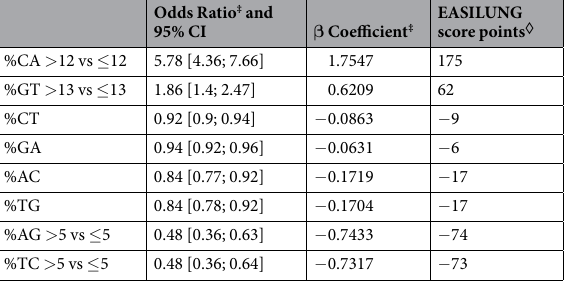
Table 3. Final logistic regression defining the EASILUNG score. ‡ Odds ratio correspond to the exponential function of the regression coefficient (e β ). ◊ β Coefficient * 100 rounded to the nearest integer CI = confidence interval; %CA = relative frequency of C > A substitutions (%); %GT = relative frequency of G > T substitutions (%); %CG = relative frequency of C > G substitutions (%); %GC = relative frequency of G > C substitutions (%); %CT = relative frequency of C > T substitutions (%); %GA = relative frequency of G > A substitutions (%); %AC = relative frequency of A > C substitutions (%); %TG = relative frequency of T > G substitutions (%); %AG = relative frequency of A > G substitutions (%); %TC = relative frequency of T > C substitutions (%); %AT = relative frequency of A > T substitutions (%); %TA = relative frequency of T > A substitutions (%).